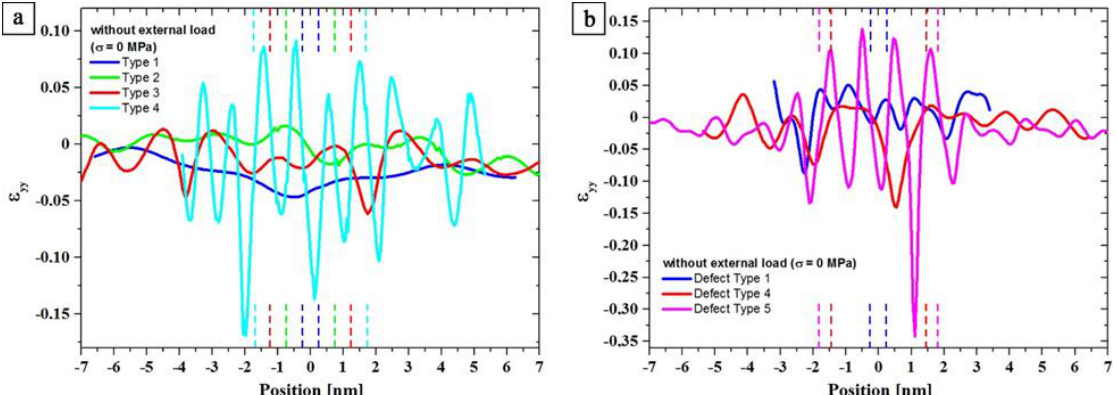
Figure 11. ε yy line profiles for different thickness and stacking of T 1 precipitate types for load free aging: ( a ) defect free stacking (Types 1–4); and ( b ) T 1 stacking with defects (Defect Types 1, 4, and 5). Position 0 refers to the mid thickness ( c /2). Vertical dashed lines indicate location of matrix/precipitate interface.